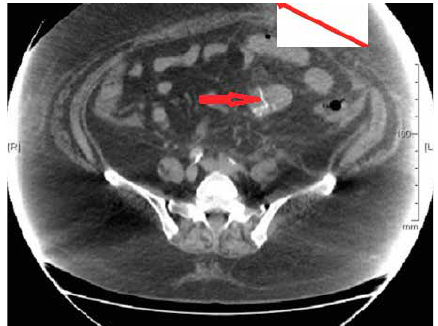
Figure 6: CT contrast scan depicting bowel anastomosis after 1st surgery (short red arrow).